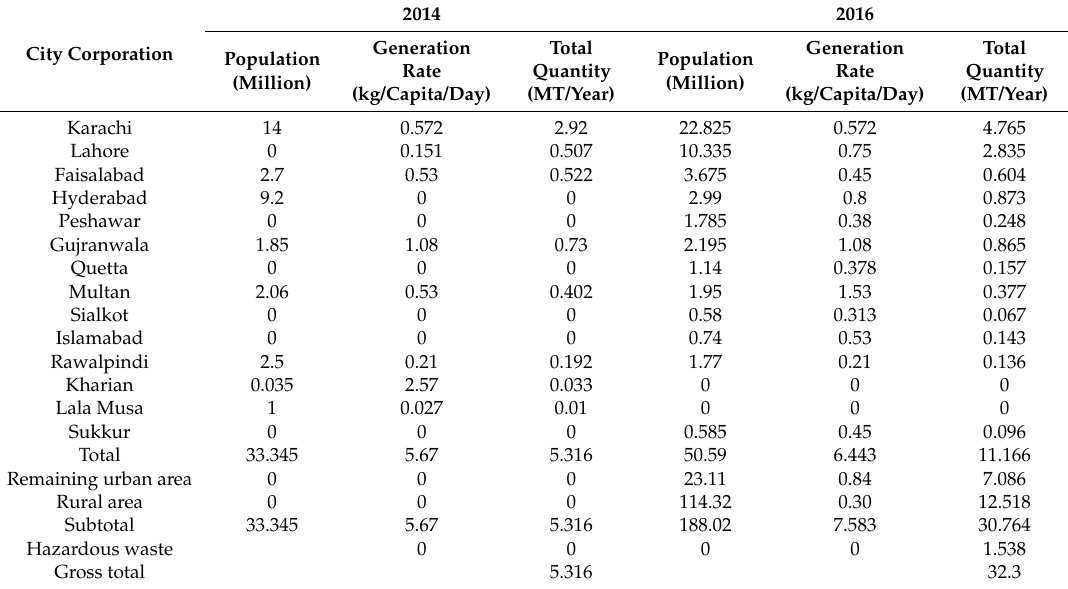
Table 16. Quantity of municipal solid waste (MSW) generated in the major cities of Pakistan in 2014 and